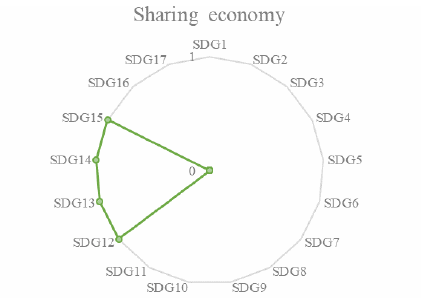
Figure 7. Construction project cluster of application effect on the SDGs